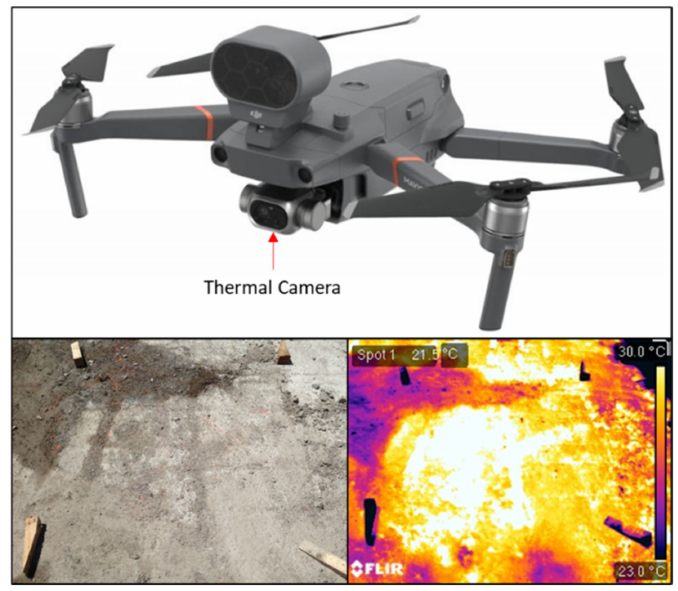
Figure 7. Typical IR-UAV equipment and sample thermography